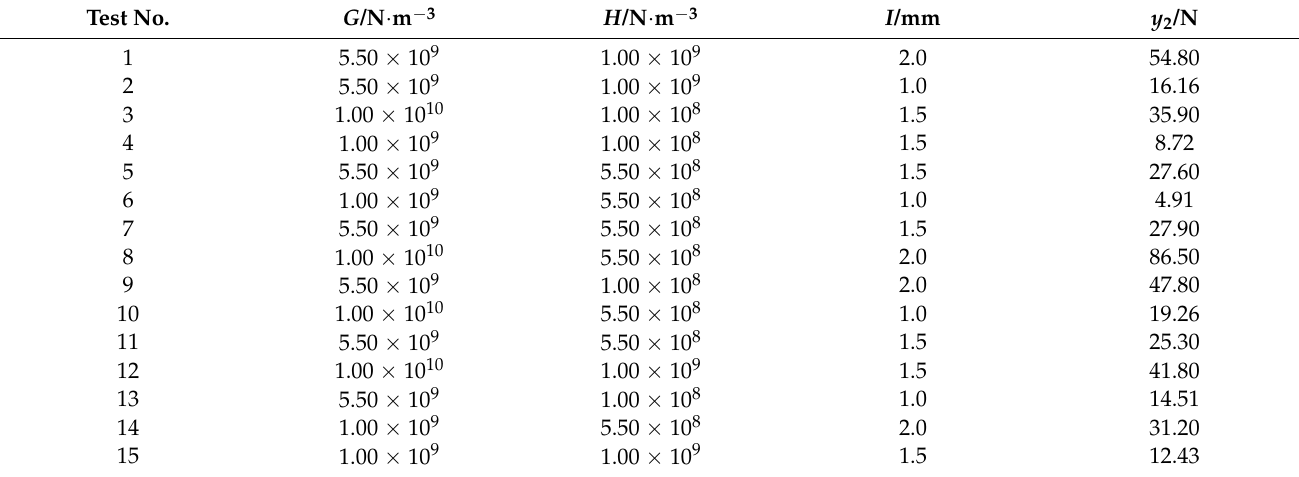
Table 7. Bonding parameter Box–Behnken simulation